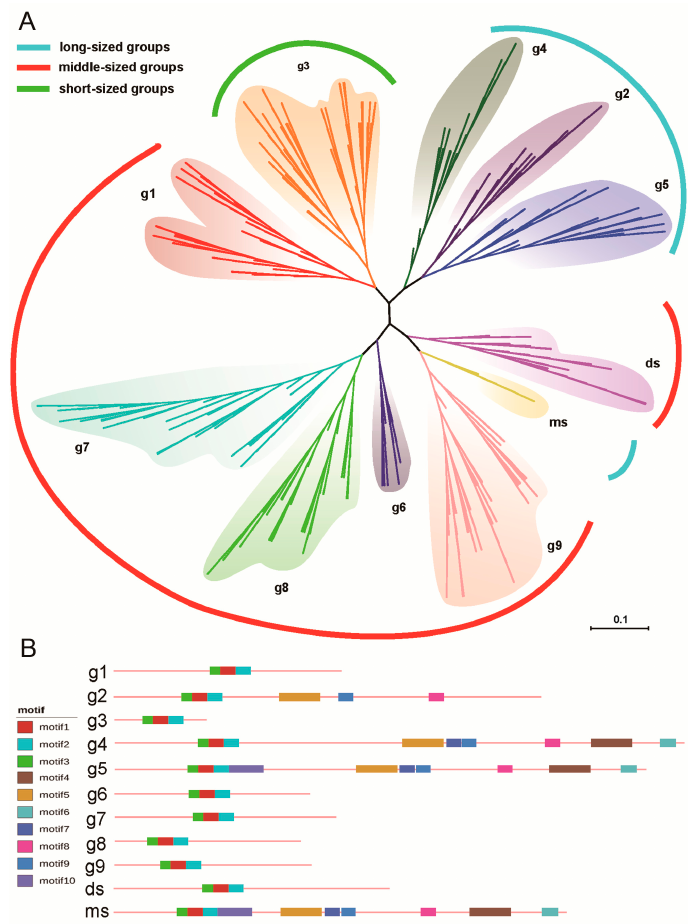
Figure 1. Phylogenetic grouping of SBP genes in flowering plants and the conservative motif structure in each group. ( A ) The phylogenetic tree of SBP genes in flowering plants. Eleven groups were obtained, namely, g1, g2, g3, g4, g5, g6, g7, g8, g9, ds, and ms. All these groups were divided into three length ranges (including the long groups, moderate-length groups, and short groups), and the groups that belonged to the same length range were marked in the same color in the outmost area. ( B ) The conserved motif of each group. The motif1, motif2, and motif3 together refer to the SBP